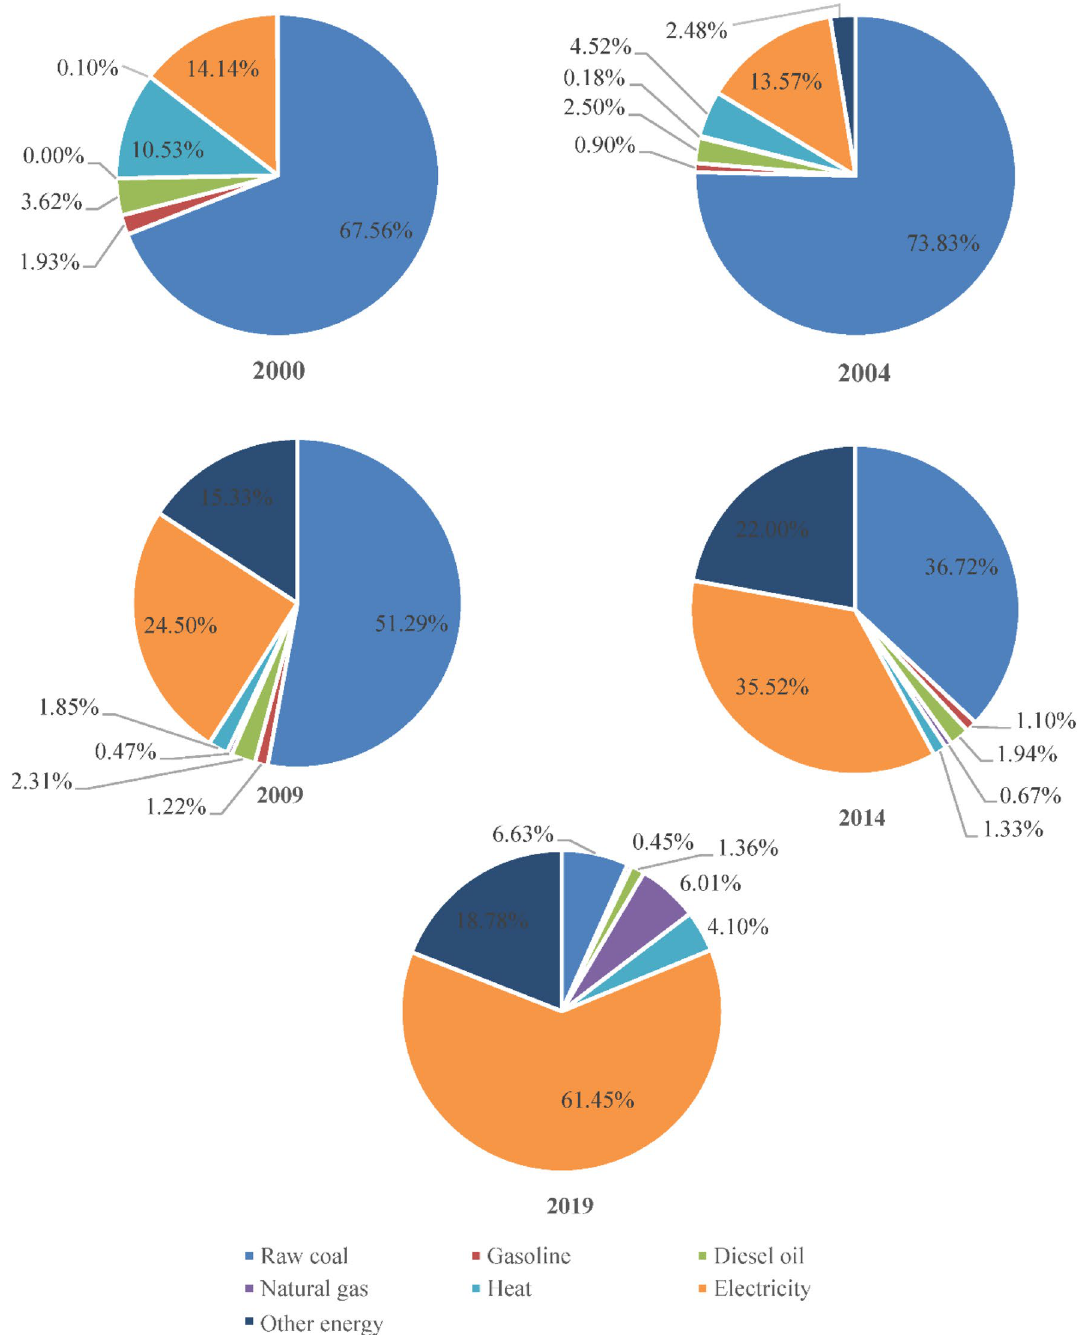
Fig. 2 Energy consumption structure of the wood and bamboo processing industry in